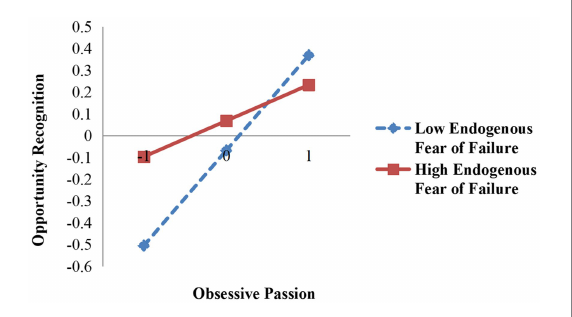
FIGURE 2 Moderating effect of endogenous fear of failure between obsessive passion and entrepreneurial performance.